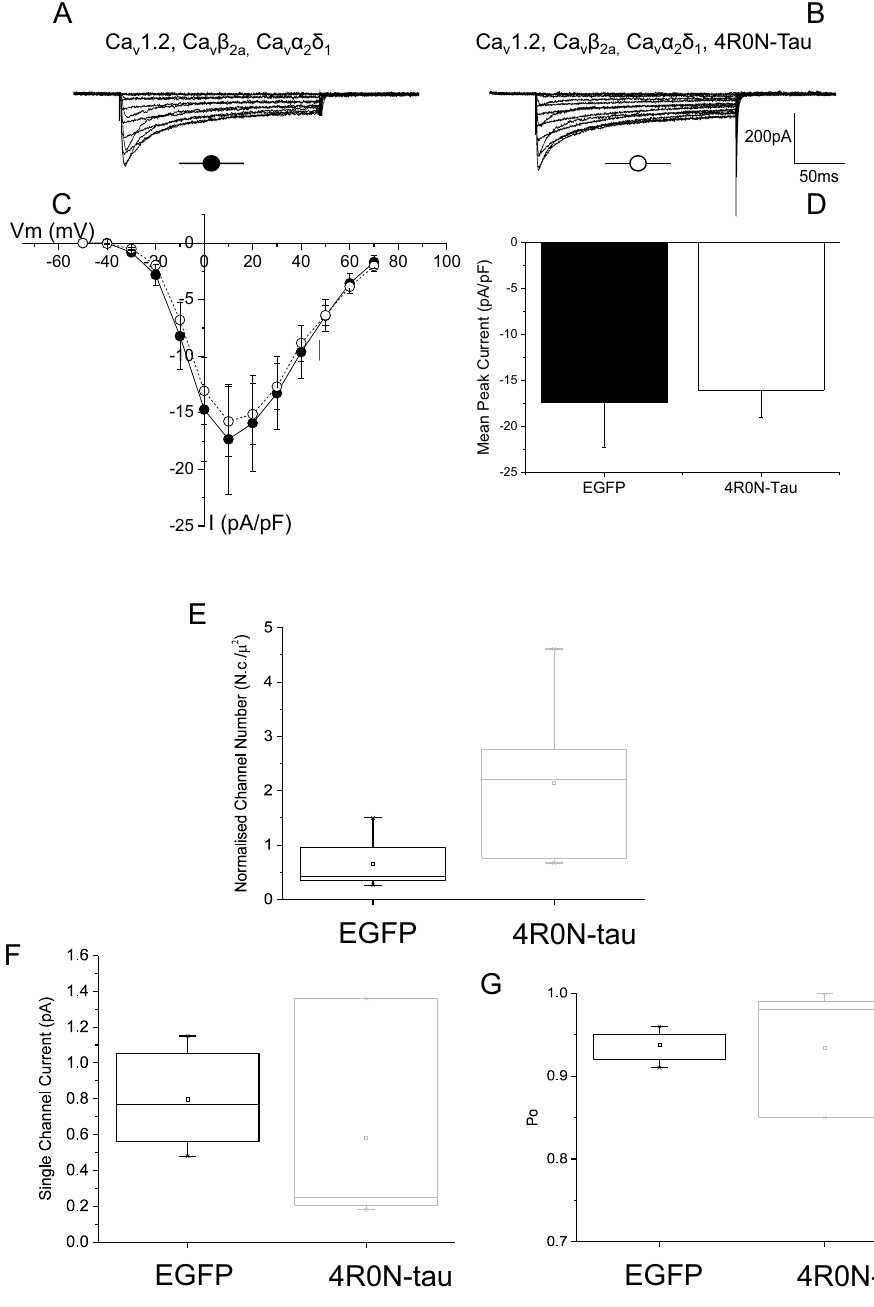
Figure 5. Effect of 4R0N-tau co-expression is dependent on the Ca v β subunit. ( A – D ) Co-expression of 4R0N- tau had no effect on the amplitude or voltage-dependence of activation of expressed Ca v 1.2/Ca v α 2 δ 1 channels when they are expressed with the Ca v β 2a subunit in tsA-201 cells. 4R0N-tau-mediated increase in Ca V 1.2- mediated L-type Ca 2+ current results from an increase in the number of functional channels. ( E ) Non-stationary noise analysis of Ba 2+ -carried Ca v 1.2, Ca v β 3 , and Ca v α 2 δ 1 L-type current showed that co-expression of 4R0N-tau (n = 7) increased channel density when compared with current from cells expressing EGFP alone (n = 6). In contrast, co-expression of 4R0N-tau had no effect on either single channel current amplitude ( F ) or channel open probability (Po) ( G